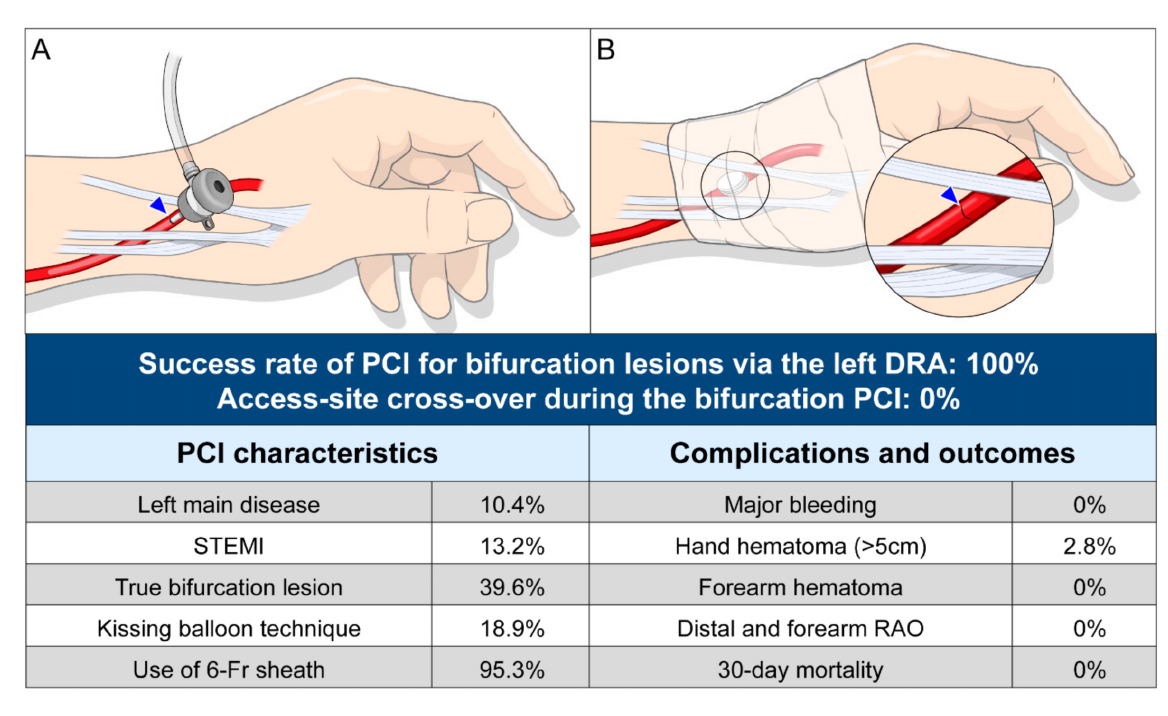
Figure 2. Positions of the patient and operator during the left DRA. The lateral ( A ) and front views ( B ) of the patient’s preparation position during the left DRA. ( C ) The natural working position of the operation while performing coronary angiography via the left DRA. Abbreviation: DRA, distal radial approach.